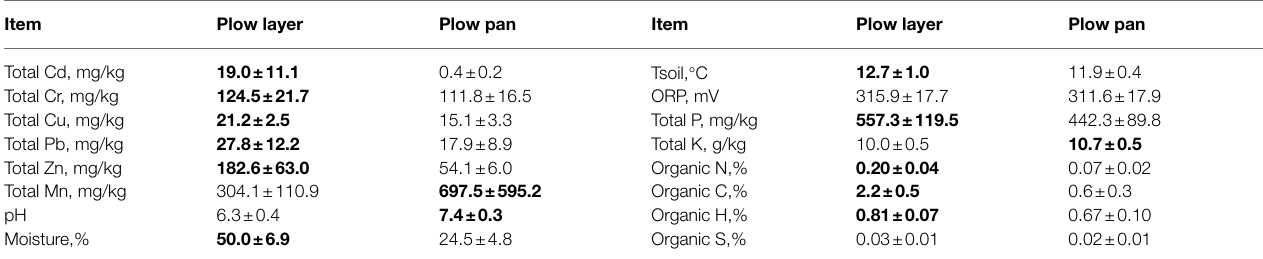
TABLE 1 | Physicochemical properties (means ± standard deviation, n = 15) analysis in the plow layer and plow pan soils.